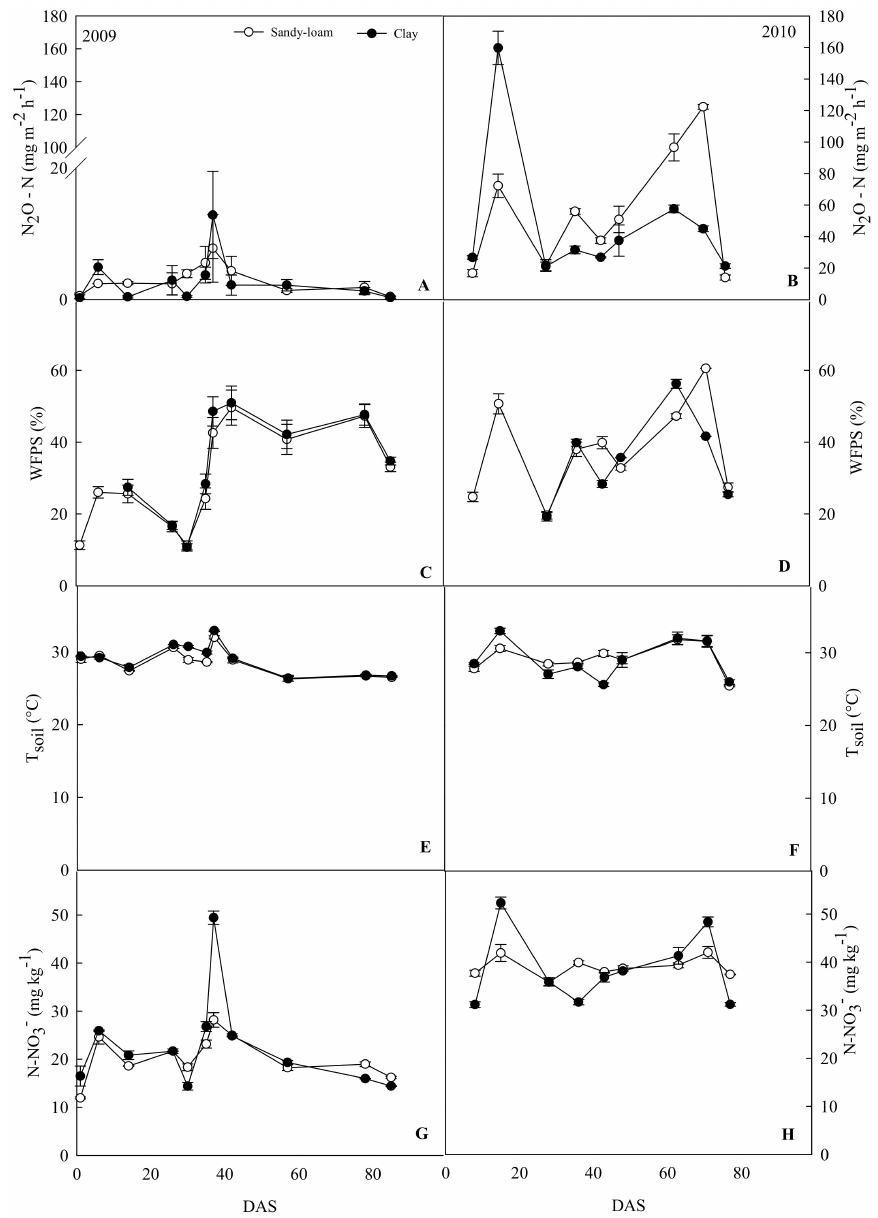
Figure 2. ( A , B ) N 2 O-N fluxes, ( C , D ) WFPS, ( E , F ) soil temperature, and ( G , H ) nitrate content, measured on clay and sandy-loam sites during 2009 and 2010 years, respectively. DAS—days after sowing. Data are means ( n = 3) ± Standard